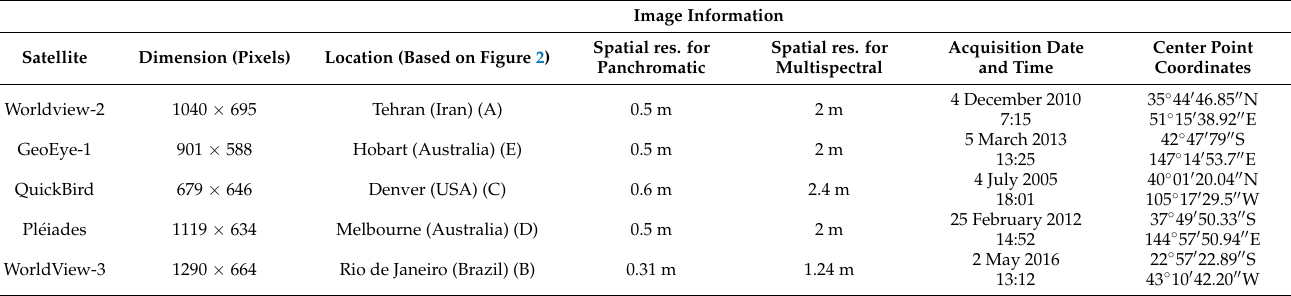
Table A1. Characteristics of satellite images utilized in this study.